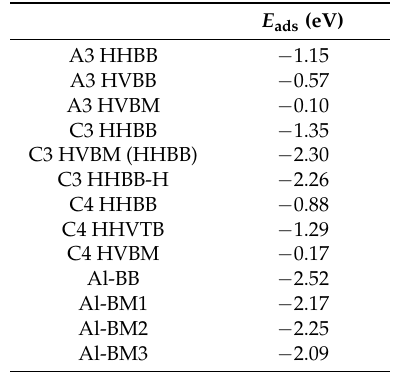
Figure 4. The C4 optimized structures. From left to right: HHBB, HHVTB, and HVBM. Aluminum, oxygen, hydrogen, and arsenic are represented by the colors blue, red, white, and green respectively. E ads and r m are the adsorption energies and averaged As–O surf distances, respectively. Table 1. Calculated E ads for all structures, based on Equation (1a) for the surfaces and (1b) for the cluster